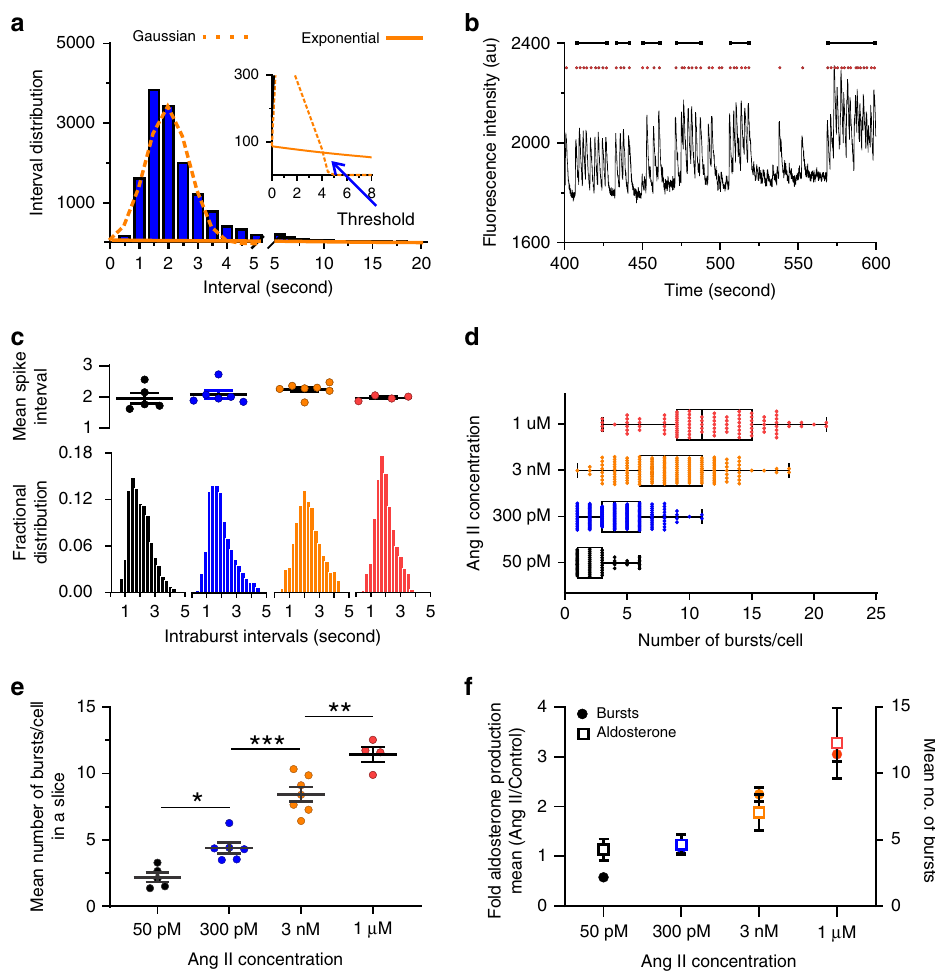
Fig. 3 Ang II dose-dependently increases the number of bursts per cell. a Histogram of binned calcium spike intervals across all cells stimulated with 3 nM Ang II and fi tted to a Gaussian function (orange dotted line) and exponential function (orange solid line). The intersection of these two functions (blue arrow) represents the threshold for discriminating between intra-burst spikes and inter-burst spikes. b Example of trace data from a zG cell stimulated with 300 pM Ang II and the subsequent spike/burst assignment. Calcium spikes (red dots) are grouped within a burst (black lines) if the distance (time) from the previous spike is less than the calculated threshold. To qualify as a burst, the spike train must contain a minimum of three consecutive sub-threshold spikes. c – f zG cells stimulated with one of four Ang II doses: 50 pM ( n = 5, 59 cells), 300 pM ( n = 6, 217 cells), 3 nM ( n = 7, 163 cells) or 1 µ M ( n = 4, 95 cells). c Top Mean spike interval per cell in a slice; no signi fi cant differences among groups were found (Kruskal – Wallis, P = 0.2071). c Bottom Fractional distribution of intra-burst calcium spike intervals was not dependent on Ang II dose, however ( d , e ) number of bursts per cell is concentration dependent ( d : median value [25 – 75%]: 50 pM: 2 (1 – 3); 300 pM: 4 (3 – 6); 3 nM: 8 (6 – 11); 1 µ M: 11 (9 – 15) ( e ): means ± SEM [bursts/cell]: 50 pM: 2.17 ± 0.36, 300 pM: 4.41 ± 0.41, 3 nM: 8.44 ± 0.54, 1 µ M: 11.44 ± 0.55) 1-way ANOVA P ≤ 0.0001; Bonferroni ’ s test: 50 pM vs 300 pM (* P = 0.029); 300 pM vs 3 nM (*** P < preparations after stimulation with one of four Ang II concentrations (left y -axis, plotted relative to unstimulated secretion, n = 5 for each concentration) correlates with the dose-dependence of burst number/cell (right y -axis). Linear regression analysis of bursts vs fold secretion yielded an r 2 of 0.88. Mean data from each mouse were represented as a single point in calculating N/experimental condition. c – f Bars, symbols are color coded according to experimental condition; 50 pM: black, 300 pM Ang II: blue, 3 nM Ang II: orange, 1 µ M Ang II: red. Source data are provided as a Source Data fi